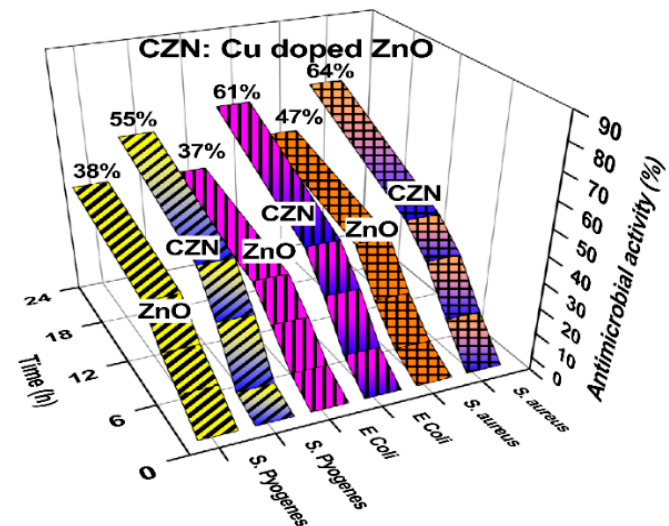
Figure 29. Antibacterial efficacy of pristine ZnO and Cu-doped ZnO nanorods using shake flask method. Reproduced from [103] with permission of Springer.